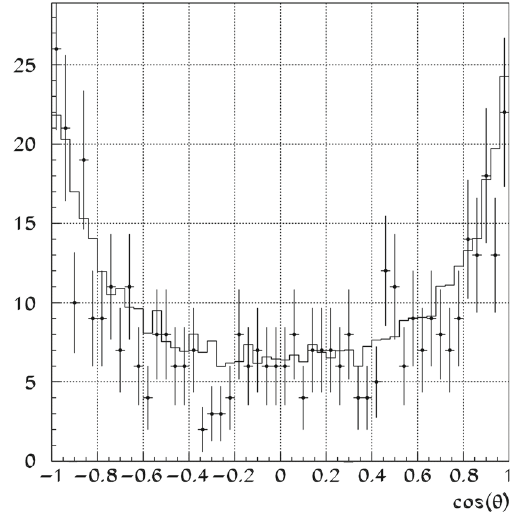
Fig. 9 The distribution (black circles) of the cosine of the angle of the photon direction with respect to the hadronic system decay plane(see the text). The histogram shows the Monte Carlo prediction for the decay K + → π + π − π + γ with the matrix element from [8]